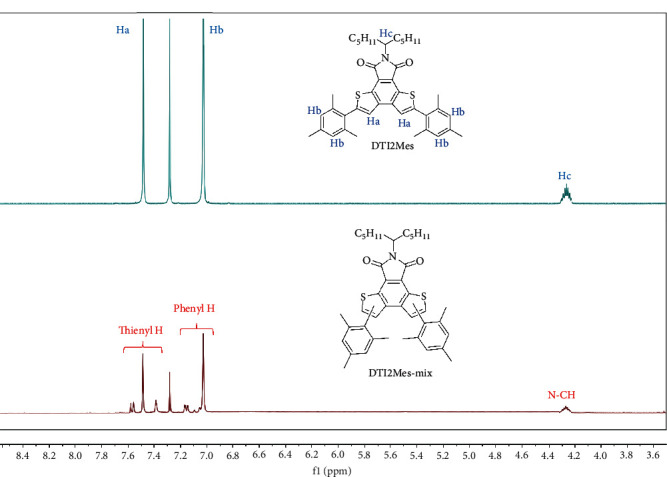

1H NMR spectra of DTI2Mes as compared with DTI2Mes-mix.